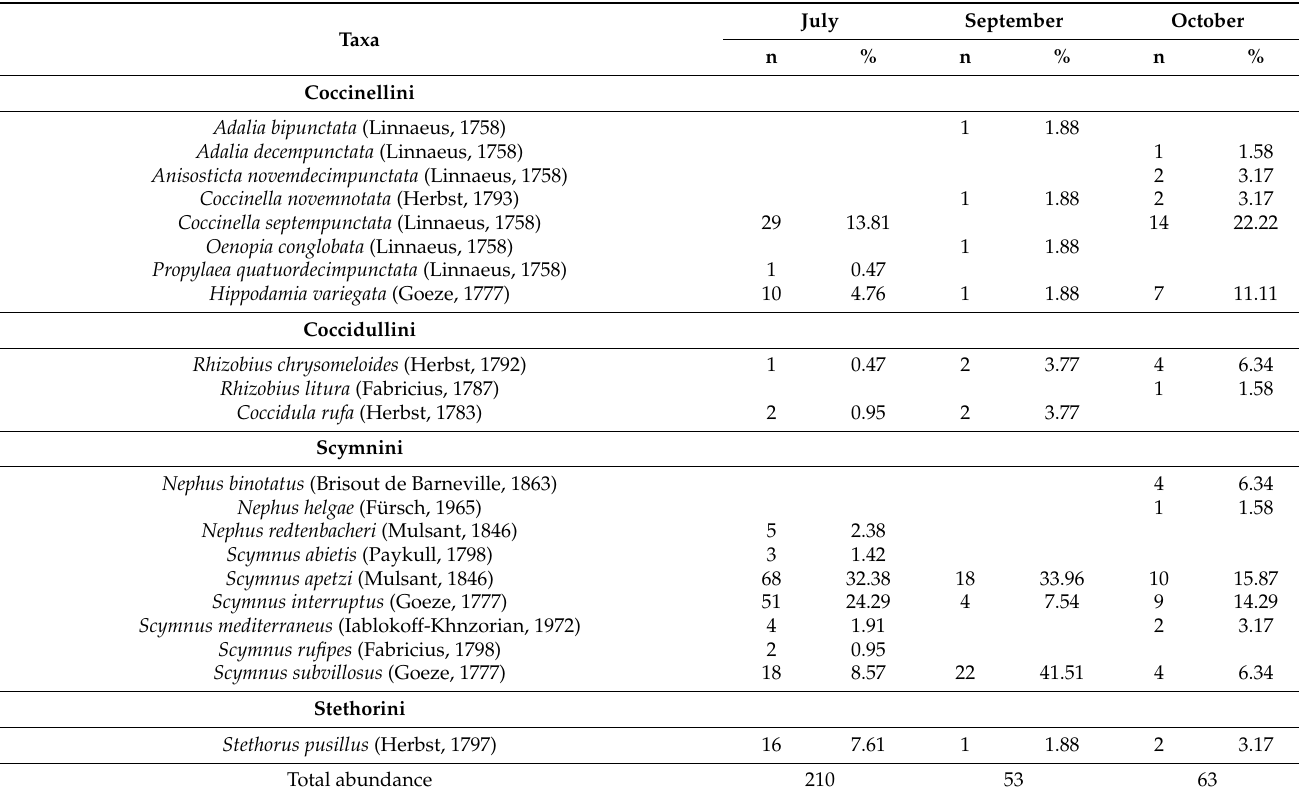
Table 1. Number of individuals (n) and percentage per sampling date (%) of Coccinellidae by tribes.